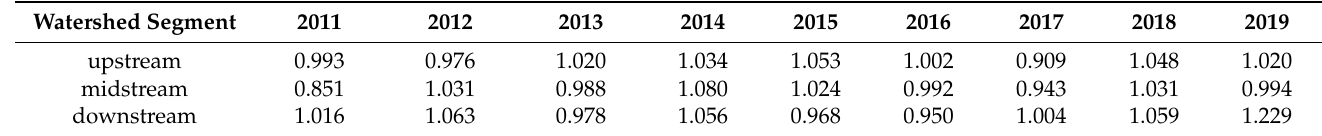
China divides the economy of the Yellow River Basin into upstream, midstream, and downstream divisions. The calculation results show that the regional high-quality devel- opment efficiency is related to the sub-watershed segment. According to the calculation results of the efficiency of each province in the Yellow River Basin (take the average of the calculated results for each province), the high-quality development efficiency value of the sub-basin of the Yellow River can be obtained, as shown in Table 3. Table 3. Calculation results of sub-basin efficiency for high-quality development in the Yellow River